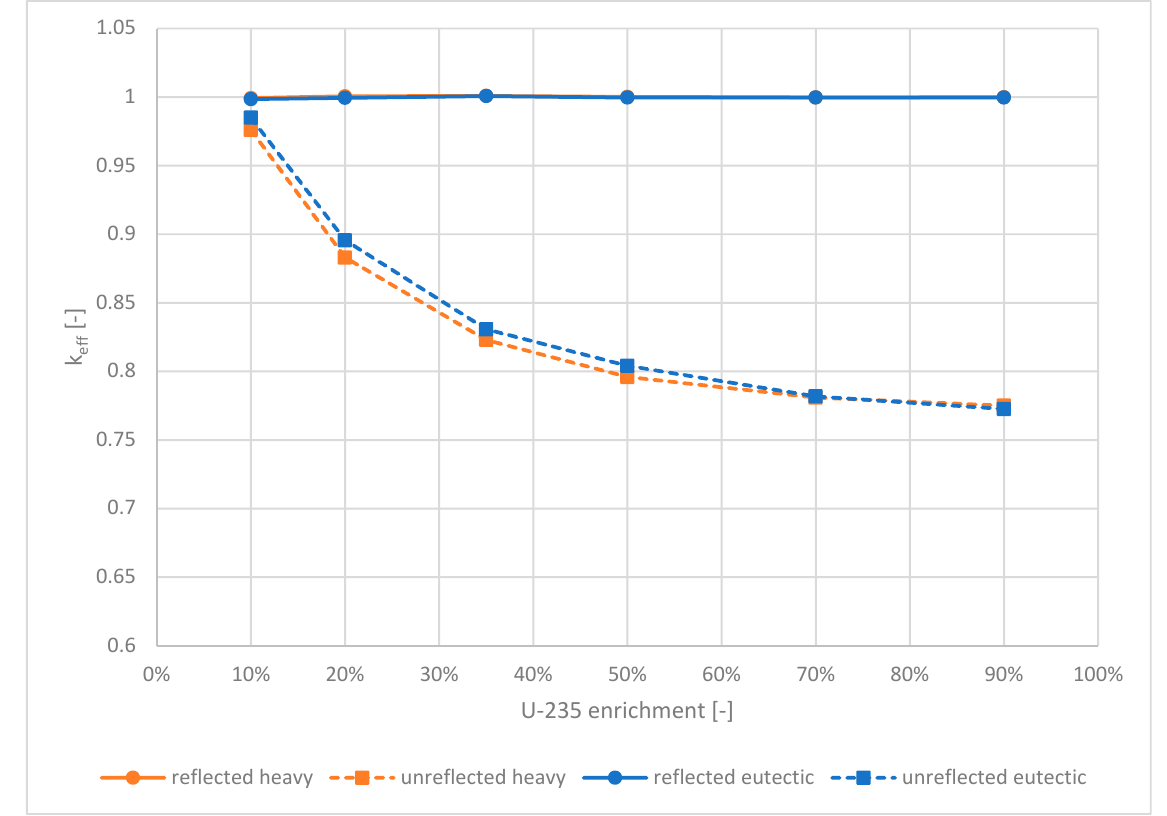
Figure 7. 2-D system criticality reduction by eliminating the reflector for the eutectic and the heavy metal rich system depending on uranium enrichment (calculated through POLARIS).